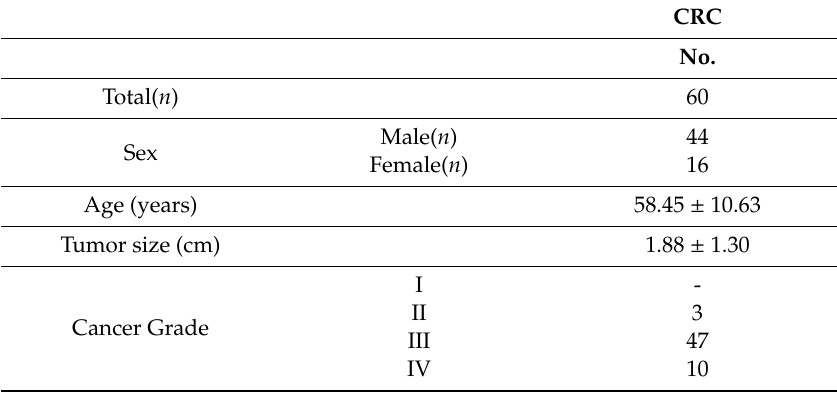
Table 2. Clinical features of paired pre- and post-surgery CRC